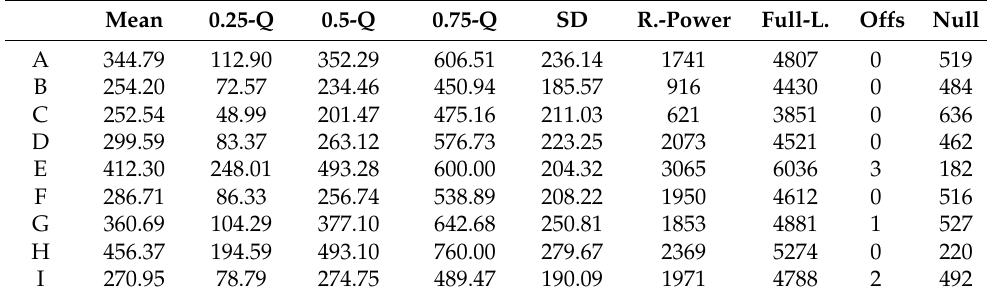
Table A2. Descriptive statistics of synthetic power production at the wind farms for the year